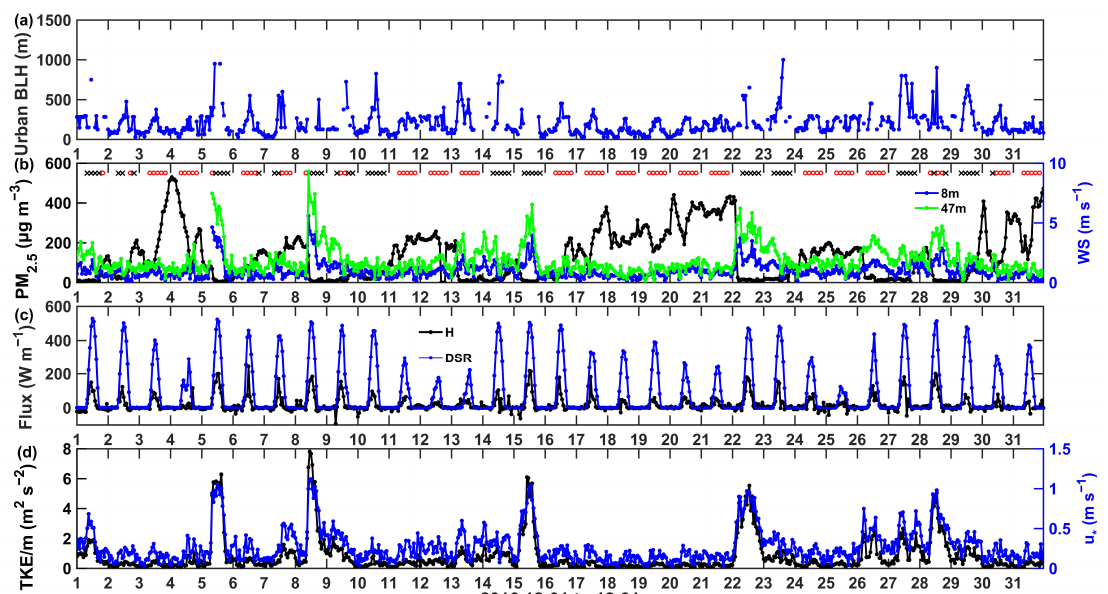
Figure 5. Diurnal cycles of urban BLH derived from threshold method combined with the Richardson number method ( a ), PM 2.5 concentration ( b ), H and DSR ( c ), and turbulent parameters, TKE and u ∗ ( d ). The cloud fraction is marked as red crosses (cloudy) and black crosses